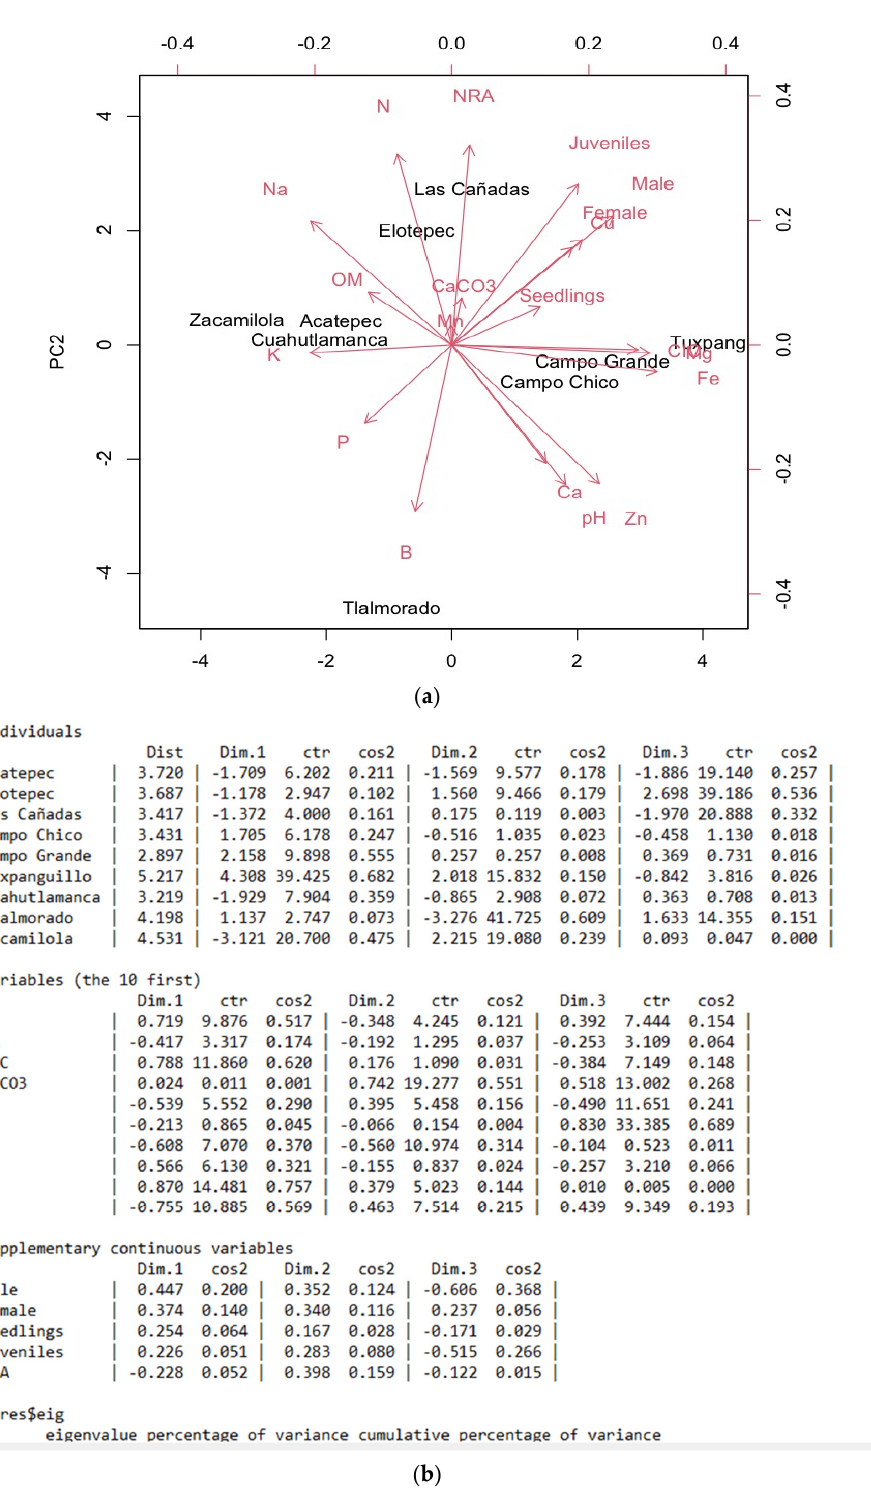
Figure 11. ( a ) Graph of population structure components and soil characteristics. O.M, Organic Material; Mn, Manganese; Na, Sodium; N, Nitrogen; CaCo 3, Calcium carbonate; Cu, Copper; CIC, Cation exchange capacity; Mg, Magnesium; Fe, Iron; Ca, Calcium; Zn, Zinc; pH, Potential hydrogen; B, Boron; P, Phosphorus; K, potassium. Tlalmorado, Zacamilola and Cuahutlamanca (Atlahuilco); Campo chico, Campo grande, and Tuxpanguillo (Ixtaczoquitl á n); Las Cañadas, Elotepec and Acatepec (Huatusco). ( b ) Correlation matrix/coefficients of structure components and soil